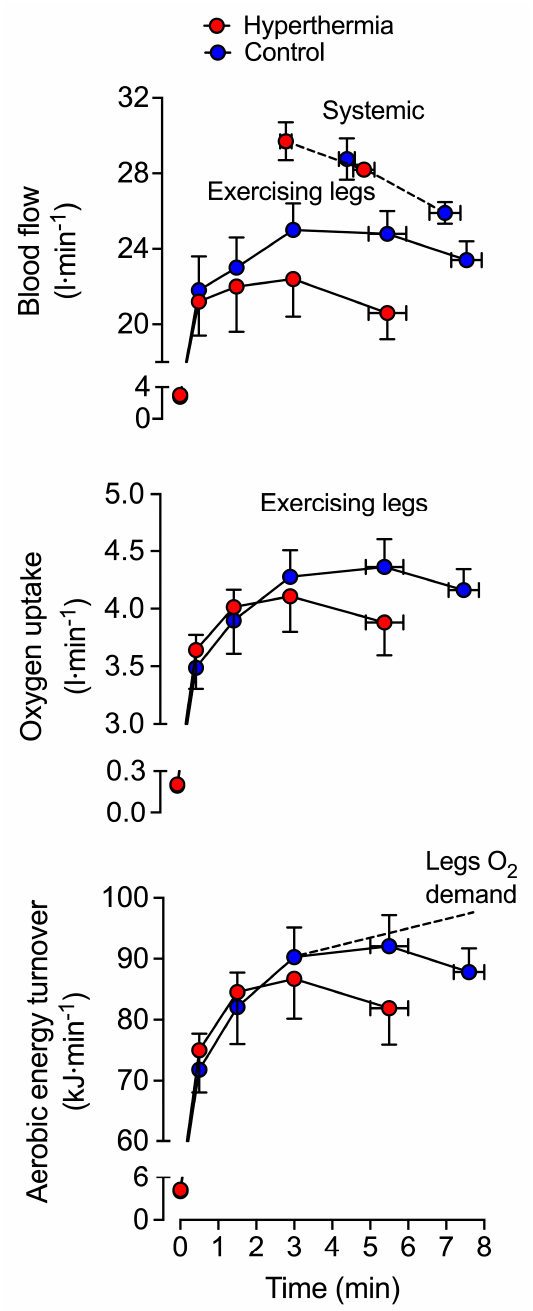
Figure 4. Impact of whole-body hyperthermia on blood flow, oxygen uptake and energy turnover during constant load maximal cycle exercise. Exercising legs (data with continuous lines) and systemic blood flow (data with dotted lines), exercising legs oxygen consumption ( V O 2 ) and aerobic energy turnover responses during constant load cycling (~360 W) to exhaustion under (1) systemic hyperthermia and (2) control (normothermic) conditions. The dotted line depicts the theoretical leg O 2 demand. Redrawn from (means ± SE) by Gonz á lez-Alonso and Calbet